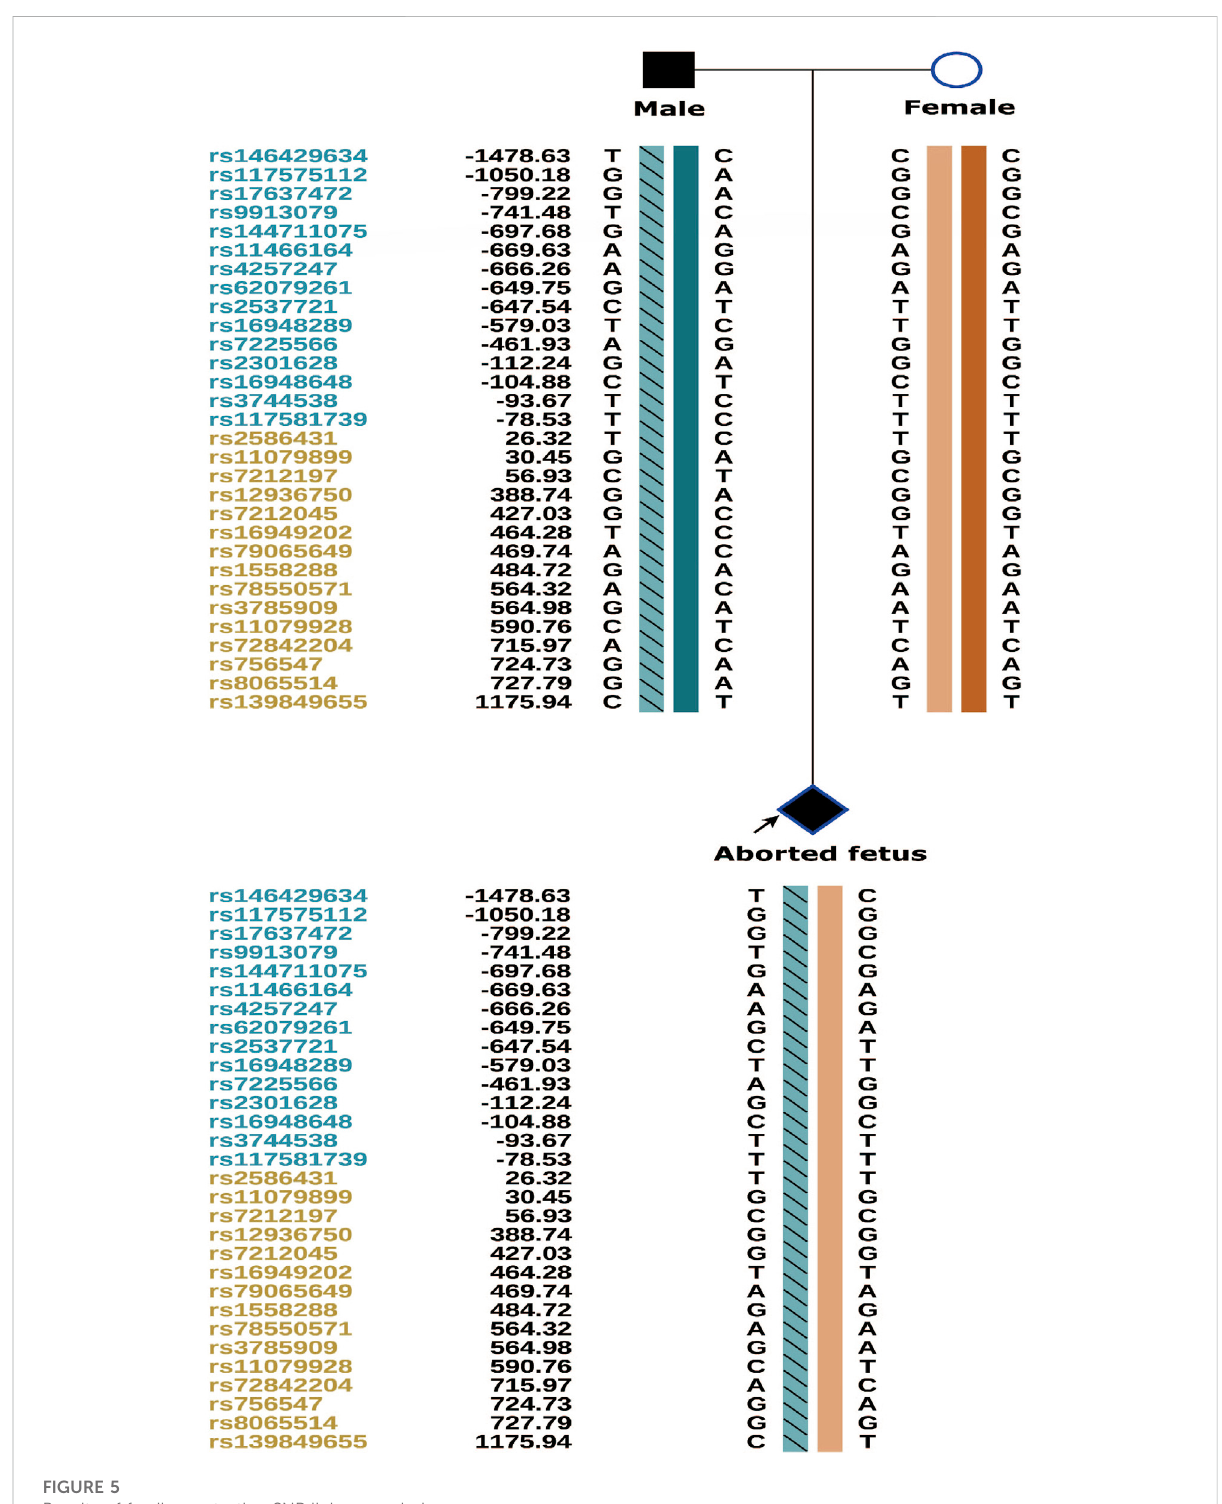
FIGURE 5 Results of family pre-testing SNP linkage